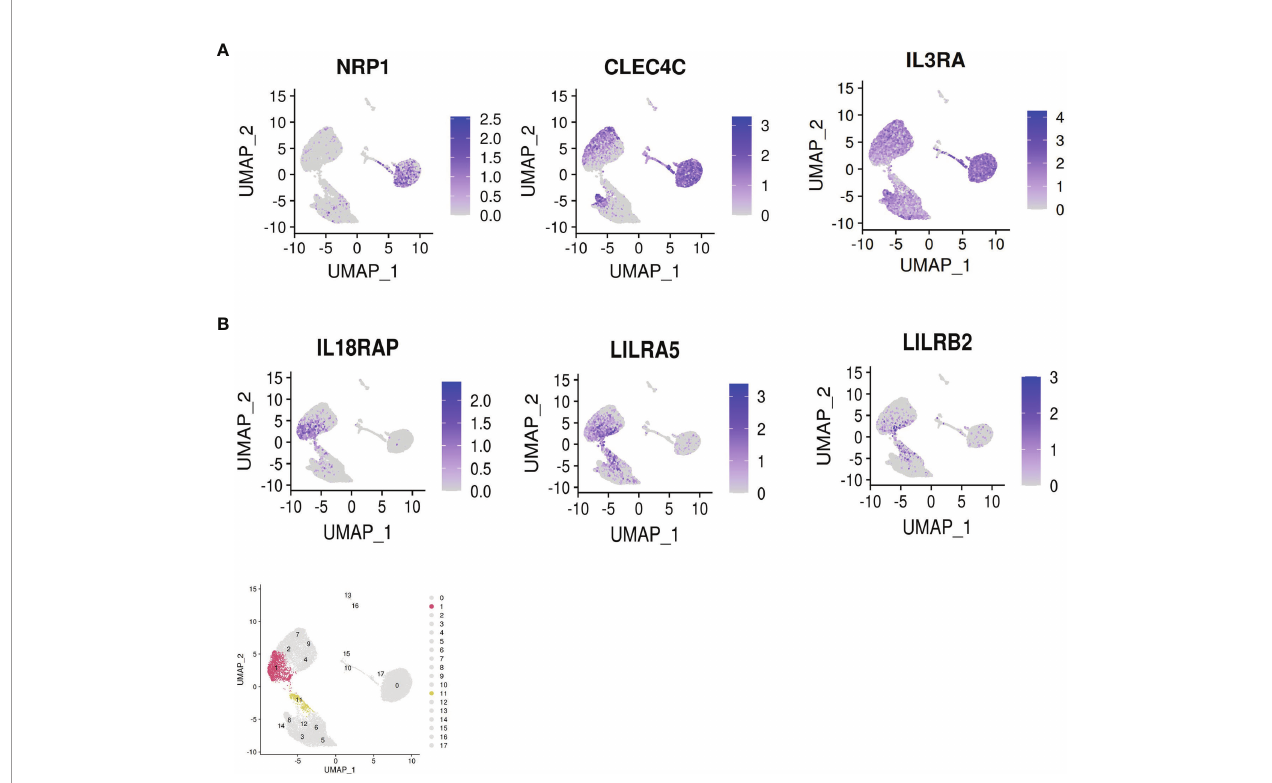
FIGURE 4 | Dropout of classical pDC markers and appearance of novel surface markers on the IFN- a + cells. (A) Dropout of the classical pDC surface antigens NRP1 [BDCA4], CLEC4C [BDCA2] and IL3RA [CD123] in the IFN-producers. (B) Novel suggested surface markers in the IFN-producers. Bottom panel: highlight of clusters 1 and 11 identi fi ed by